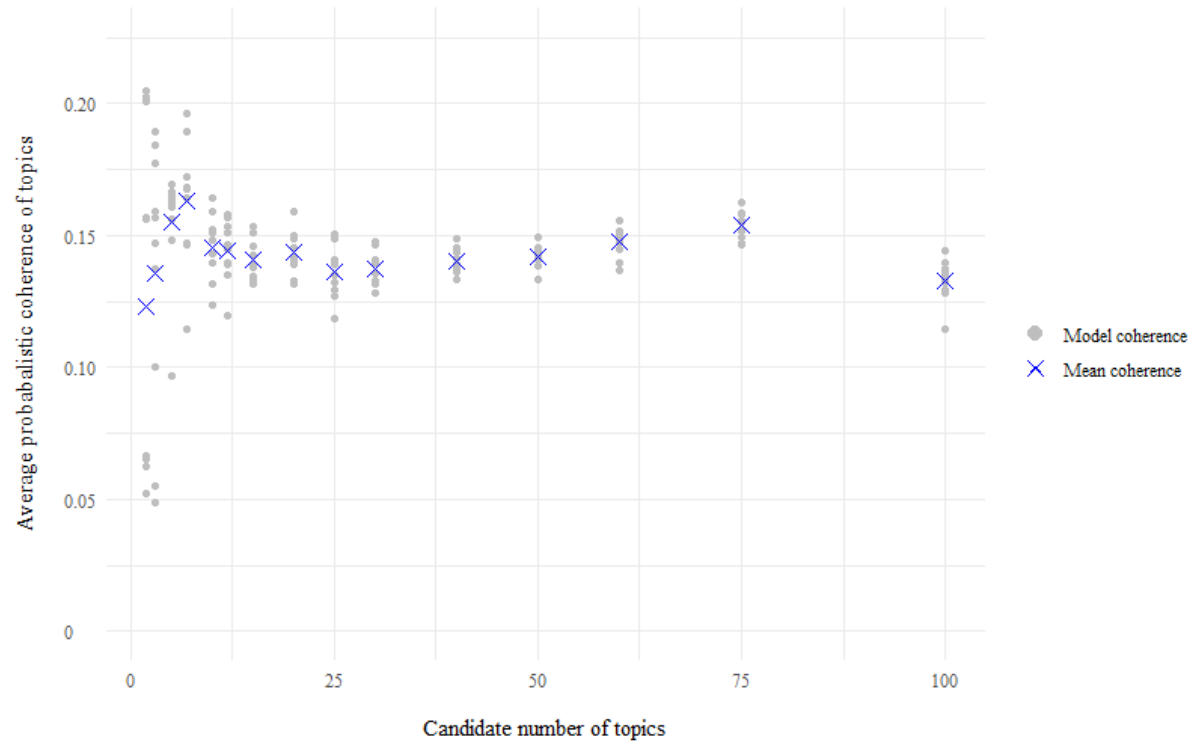
Figure 3. Average probabilistic coherence scores for the models—LifeInfo store loyalty card question, 10-fold cross-validation of topic modelling to establish the optimal number of topics for latent Dirichlet allocation.